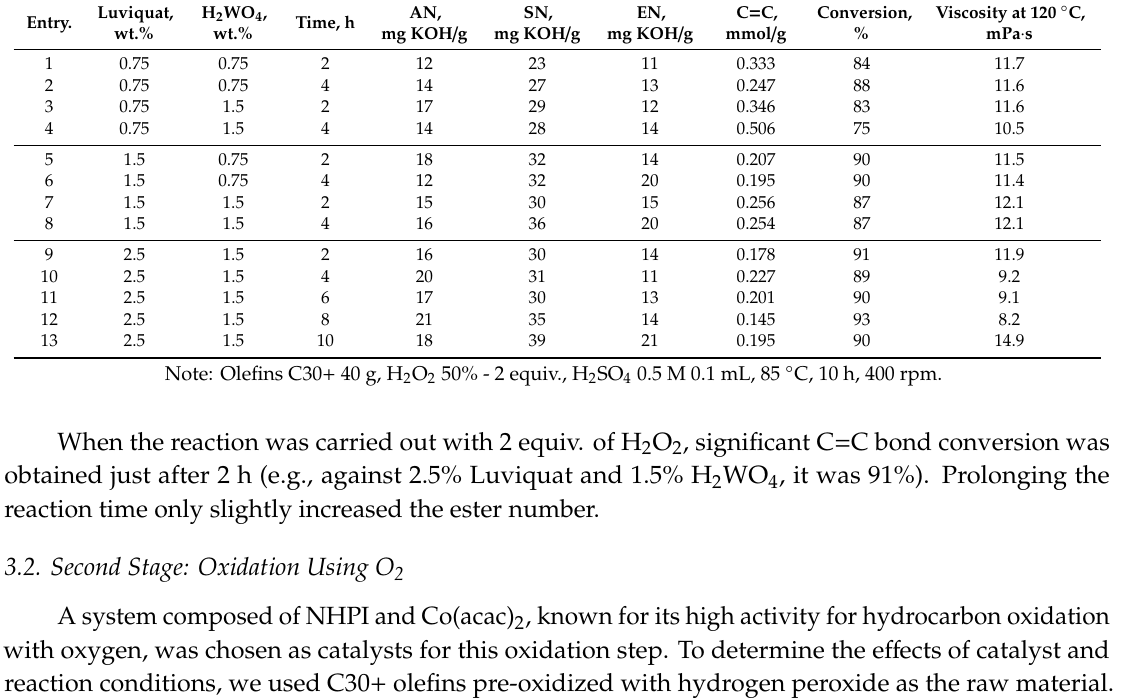
Table 4. E ff ect of reaction time on the C30 + olefins oxidation using H 2 O 2 . Entry.